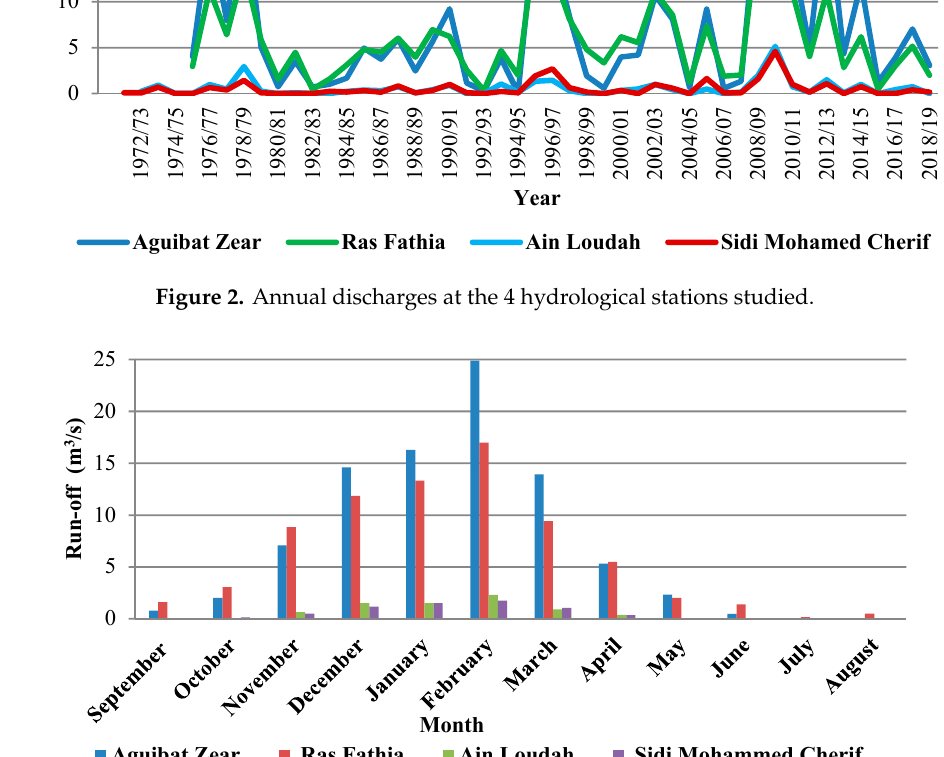
Figure 3. Mean monthly discharges at the hydrological stations studied. Table 3. Flood events for the four hydrological stations